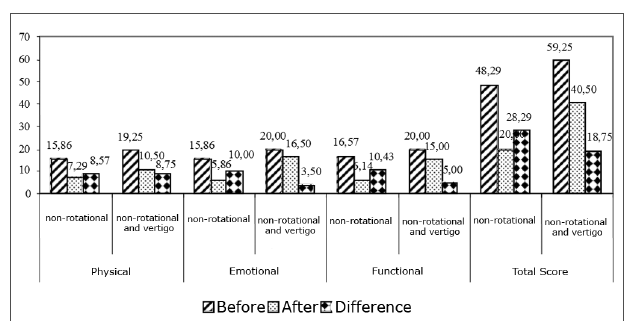
the Brazilian DHI after VR.